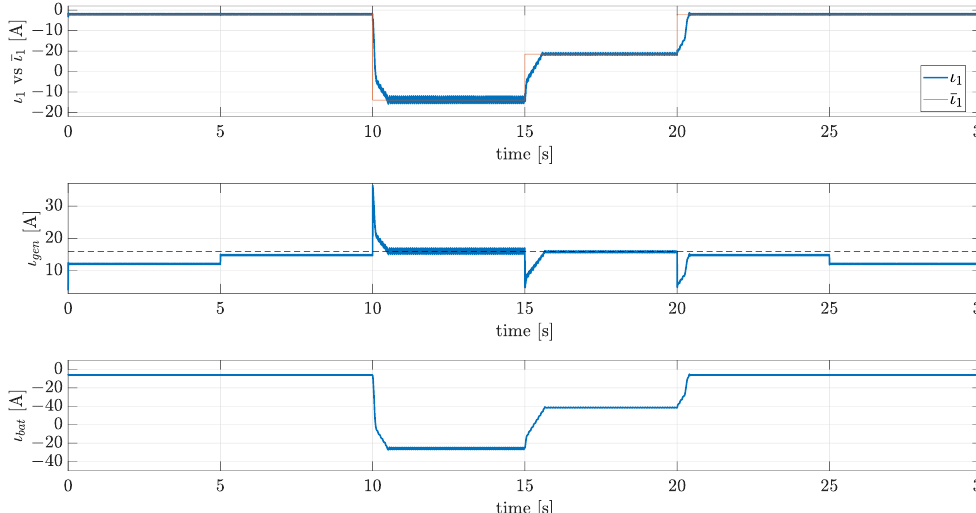
Figure 8. Buck mode. From top to bottom: converter input current ι 1 ( blue solid line ) and current reference ¯ ι 1 ( red solid line ); generator current ι gen ( blue solid line ) and its threshold value ( black dashed line ); battery current ι batt ( blue solid line ).